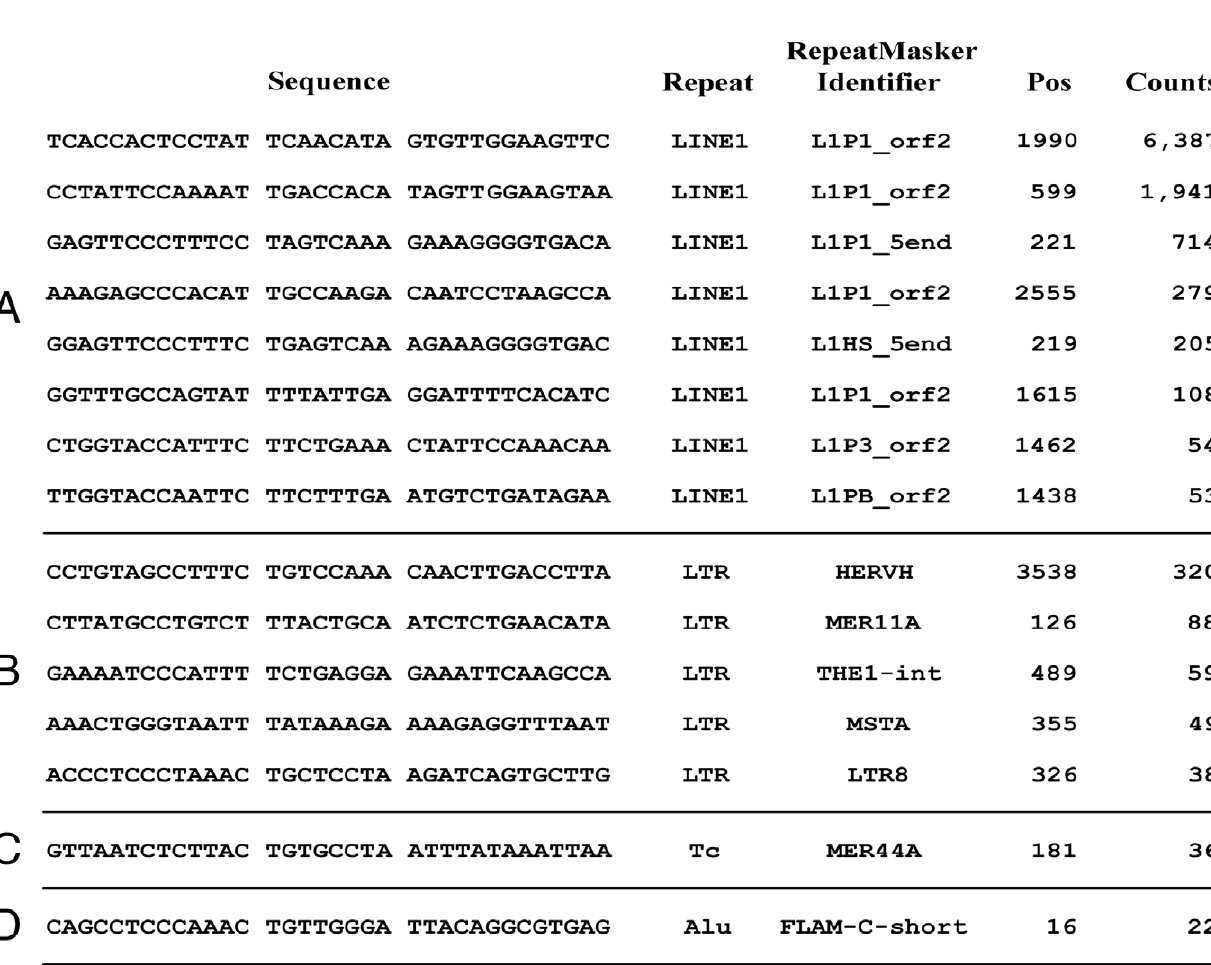
Figure 6. FRT -like sequences in repeated DNA sequences in human genome . Examples of repeated FRT -like sequences in ( A ) LINE-1, ( B ) LTRs of endogenous retroviruses, ( C ) Tc element, ( D ) Alu repeats.